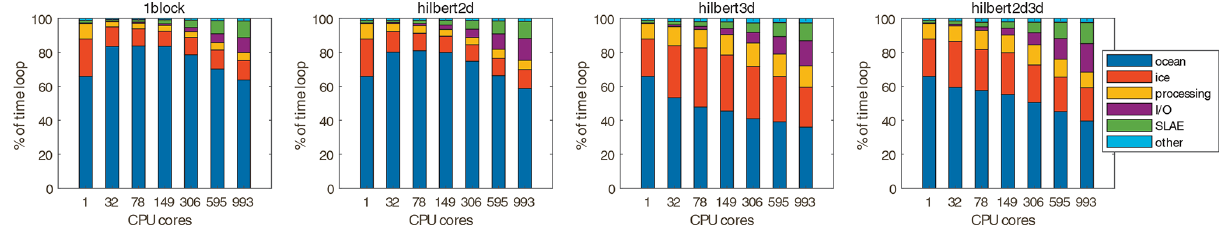
Figure 8. Relative contribution of different code sections to runtime; ocean – all procedures corresponding to ocean submodel including advect3D , ice – ice submodel including iceadvect , processing – computation of statistics, I/O – input/output with scatter–gather functions, SLAE – matrix inverse, other – simple service procedures.